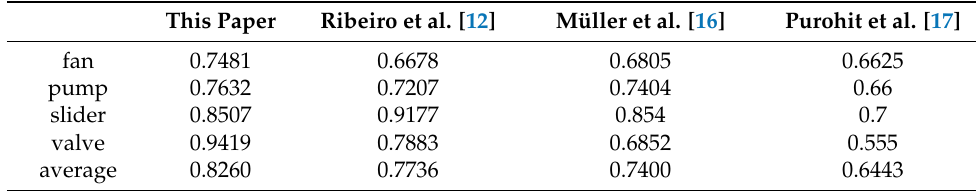
Table 6. Comparison with other papers.